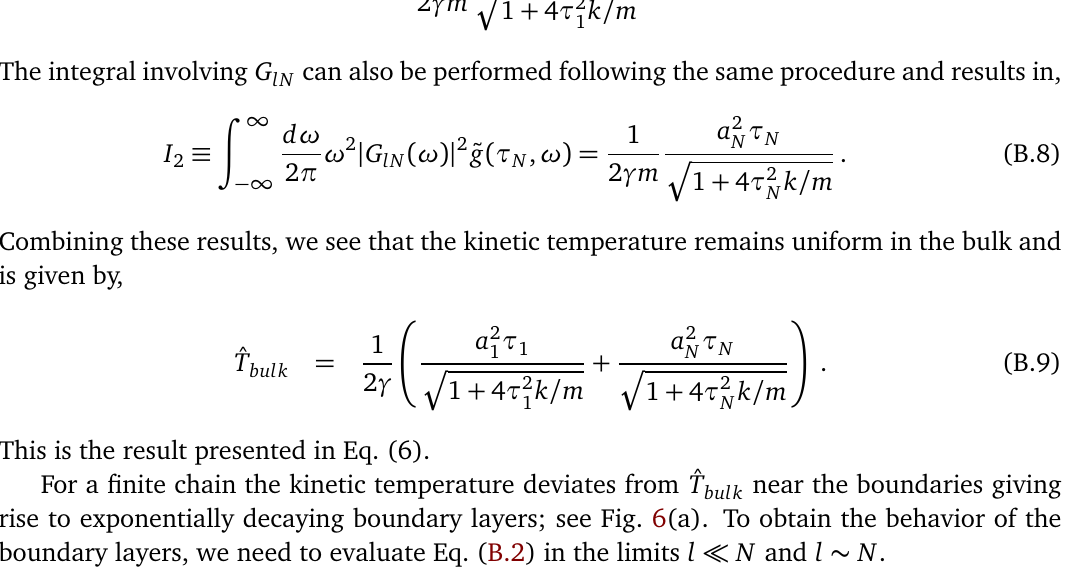
from ˆ T at the l bulk = 1. 1 is much larger 1, N = 1